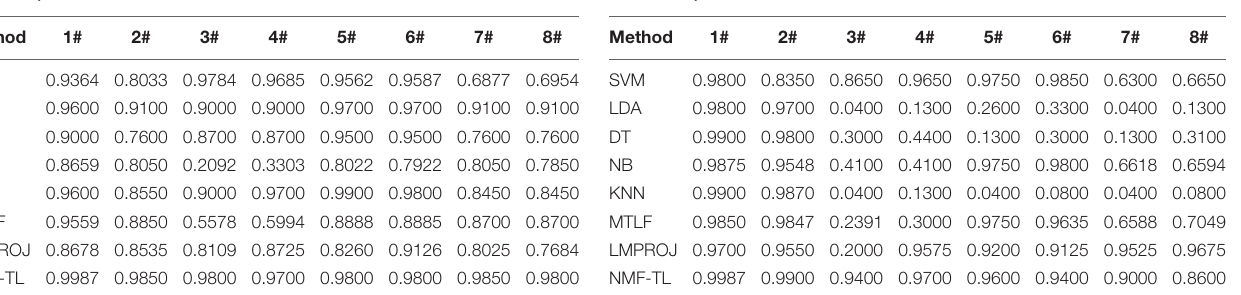
TABLE 10 | Recall of 8 classifiers on datasets based on SITF feature extraction.